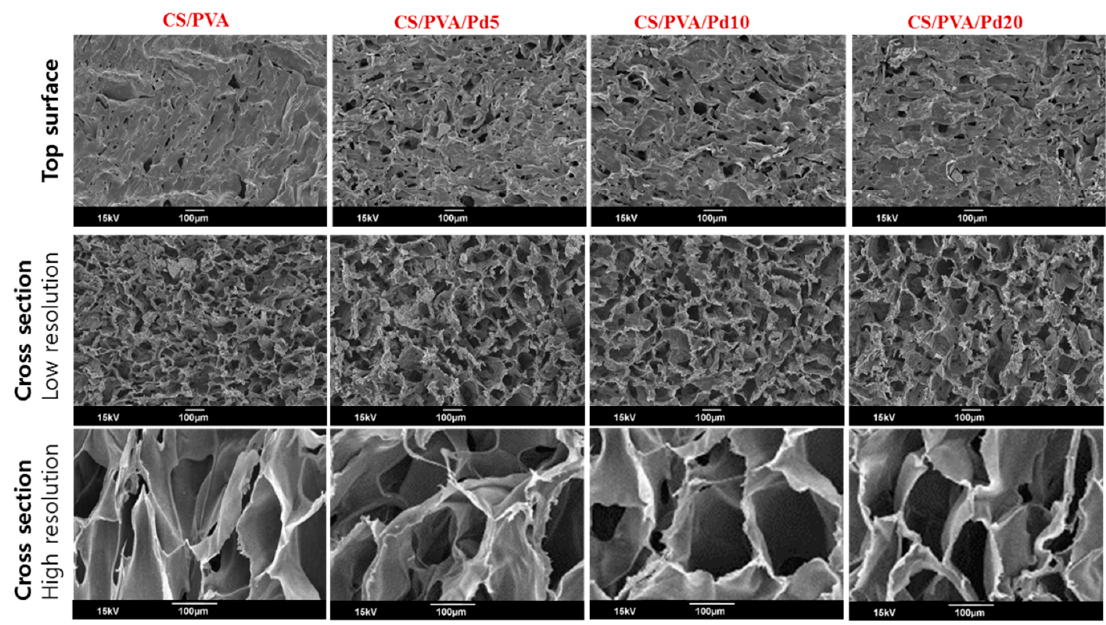
Figure 3. Scanning electron microscope (SEM) of CS/PVA and CS/PVA/Pd dressings.